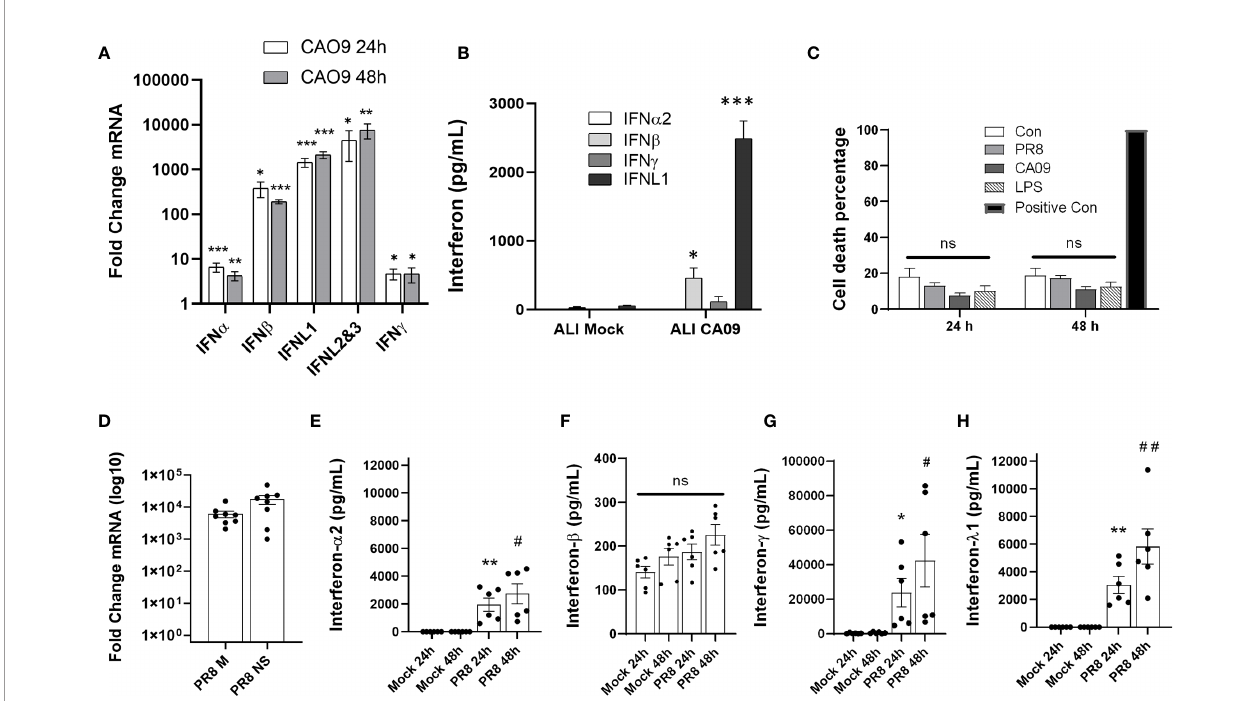
FIGURE 1 | In fl uenza infection induces IFNL1 in the airways. Differentiated human airway epithelia cells were seeded on permeable supports. Cells were then infected with in fl uenza CA09 (MOI=1) or mock infected for the indicated time. Interferon gene induction via qRT-PCR. n =3 independent experiments, n= 9 samples per group (A) . Basolateral medium (24h post-infection) from permeable supports were tested for interferon cytokines using the U-PLEX Interferon Combo (Meso Scale Discovery). n =3 independent experiments, n= 9 samples per group (B) . Multiple T-test with Holm-Sidak correction. *p < 0.05, **p < 0.01, ***p < 0.001 vs. mock or uninfected controls (A, B) . Human precision cut lung slices (PCLS) were infected with PR8 (1.25 x 10^ 6 pfu) and CA09 (2 x 10 ^7 pfu). The release of LDH into the supernatant was analyzed to determine cell viability. Positive control: sonicated lung tissue to release all LDH into the supernatant. n =2 independent experiments from 2 donor lungs, n=6 samples per group. (C) . Con fi rmation of in fl uenza infection of lung slices by qRT-PCR. n =3 experiments, n =8 samples per group (D) . Supernatant of infected lung slices was removed at 24-48 h post-infection and assayed for IFN a , IFN b , IFN l , or IFN g with the U-PLEX Interferon Combo (Meso Scale Discovery). ns, not signi fi cant. n =2 independent experiments from 2 donor lungs, n=6 samples per group. *p < 0.05, **p < 0.01 vs. 24h control, # p < 0.05, ## p < 0.01 vs. 48h control (E – H)